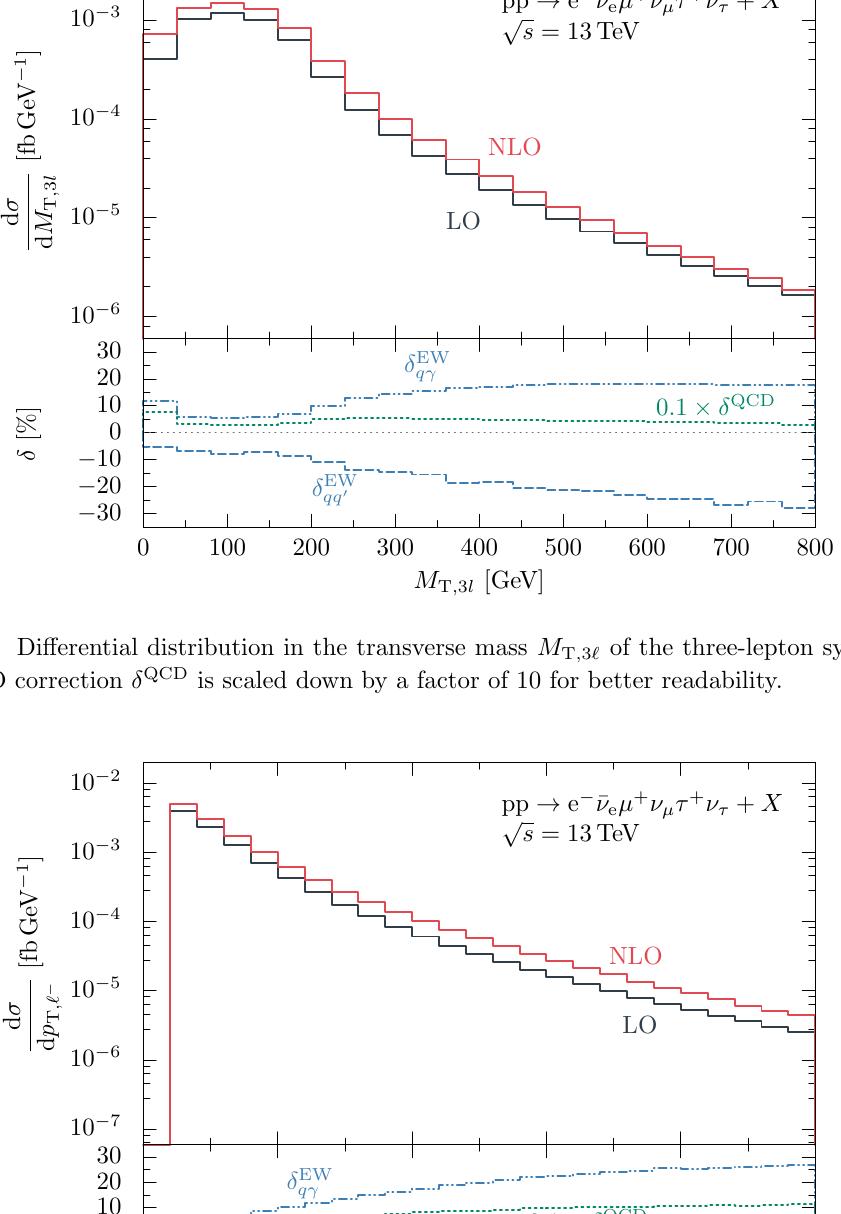
of the negatively charged T ;‘ (cid:0)